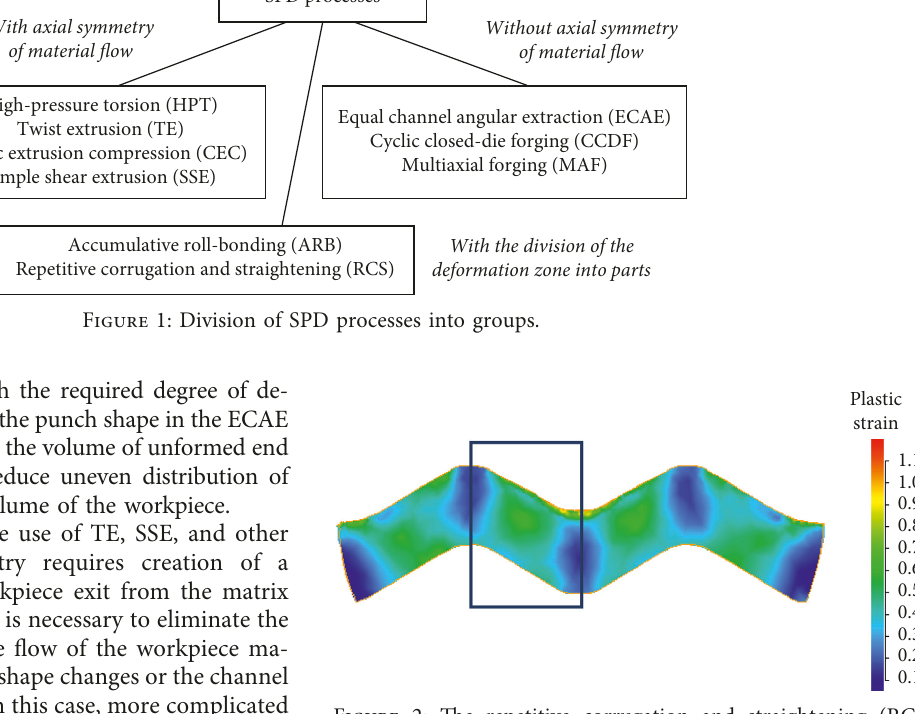
Figure 2: The repetitive corrugation and straightening (RCS) deformation process scheme